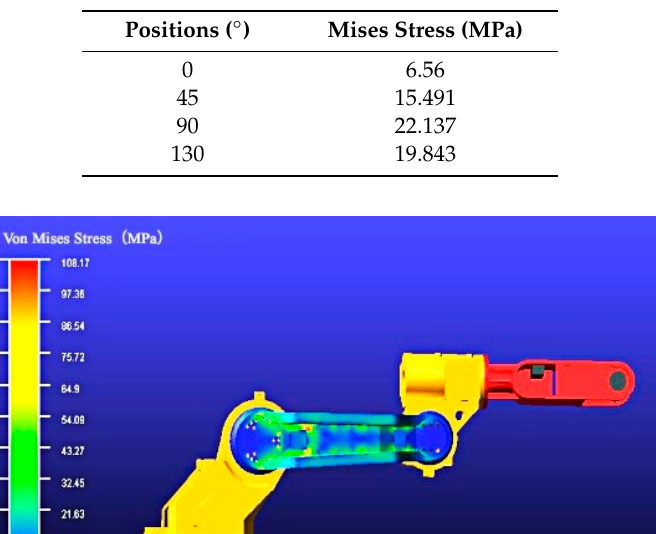
Figure 8. Simulation of the upper arm at different positions, ( a ) 0° of the rotating position, ( b ) 45° of the rotating position, ( c ) 90° of the rotating position, ( d ) 130° of the rotating position. Table 2 showed the maximum stress at different rotating positions. Table 2. Maximum stress at different rotating positions of the upper arm.